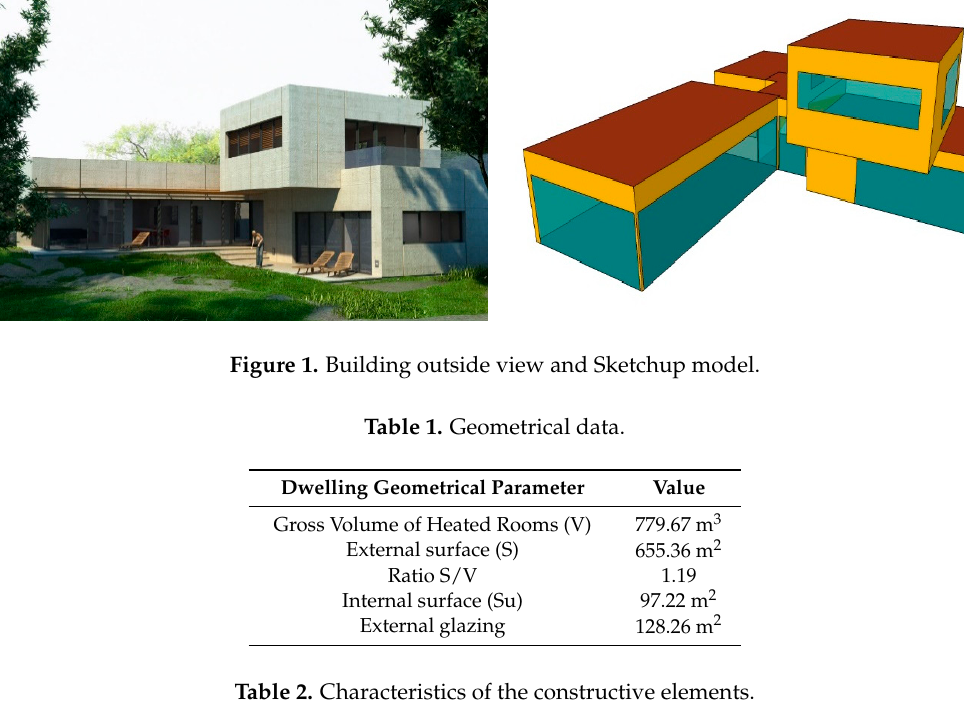
Table 2. Characteristics of the constructive elements.